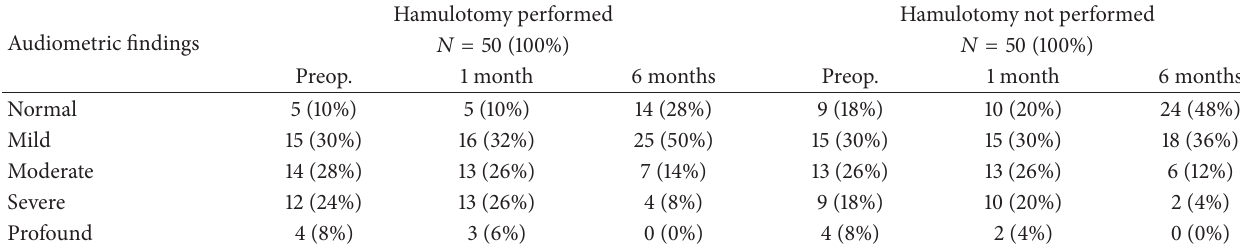
Table 2: Audiometric findings in study subjects.